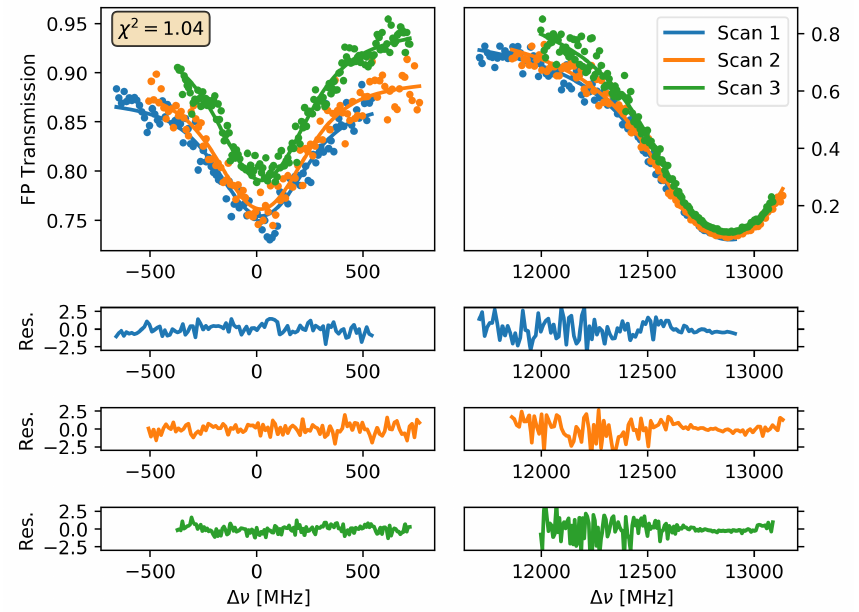
Figure 3. FP transmittance of the absorbed comb modes resonant with the(20 0 1-00 0 0) R(18) of 13 C 16 O 2 (left side graphs) and (20 0 1-00 0 0) P(45) of 12 C 16 O 2 (right side graphs) transitions and the fit to the T ( ∆ ν ,P, T) (Equation (4)) of all recorded spectra by using the global fit procedure. P = 55.0 mbar and T = 296 K for the CO 2 gas sample for all acquisitions. The reduced χ 2 of the global fit is also